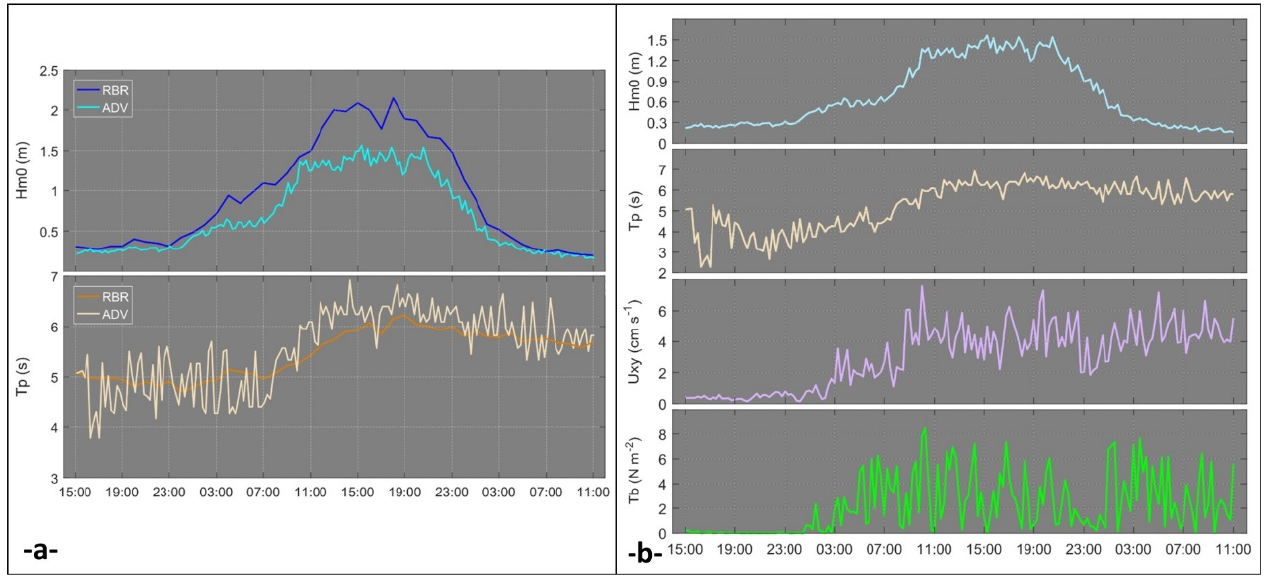
Figure 5. Wave characteristics extracted from the RBR records: ( a ) zero-moment wave height, ( b ) peak wave period, ( c ) maximum recorded wave height, ( d ) wave period corresponding to the maximum wave heights, and ( e ) wave energy corresponding to the zero-moment wave heights.